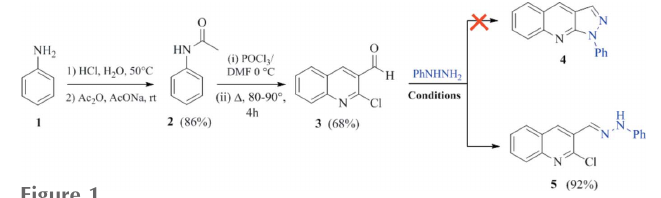
Figure 1 Reaction scheme: condensation of 2-chloro-3-formylquinoline with phenylhydrazine.